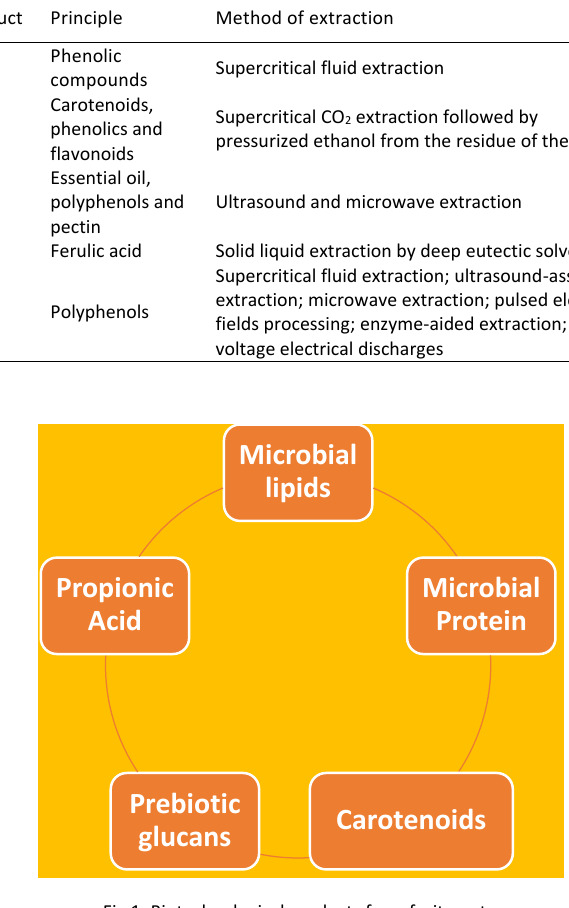
Fig 1: Biotechnological products from fruit wastes